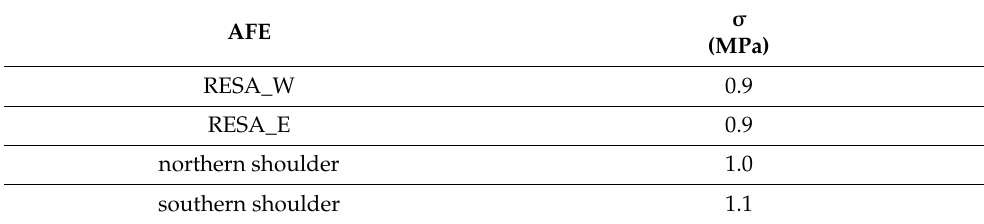
Figure 17. Results of the strength of the turf layer of the airfield pavement on the runway end safety areas. Table 8. Average values of the strength of the AFE’s turf layer.